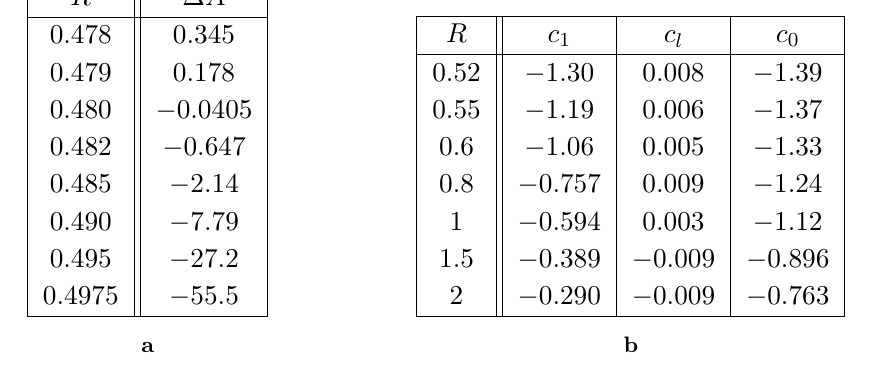
Table 2. Left: The (finite) area difference ∆ A = A bridge − A cap between the bridge and cap surfaces for a range of R . Right: Entropy coefficients defined in eq. (4.5) for the corner phase.